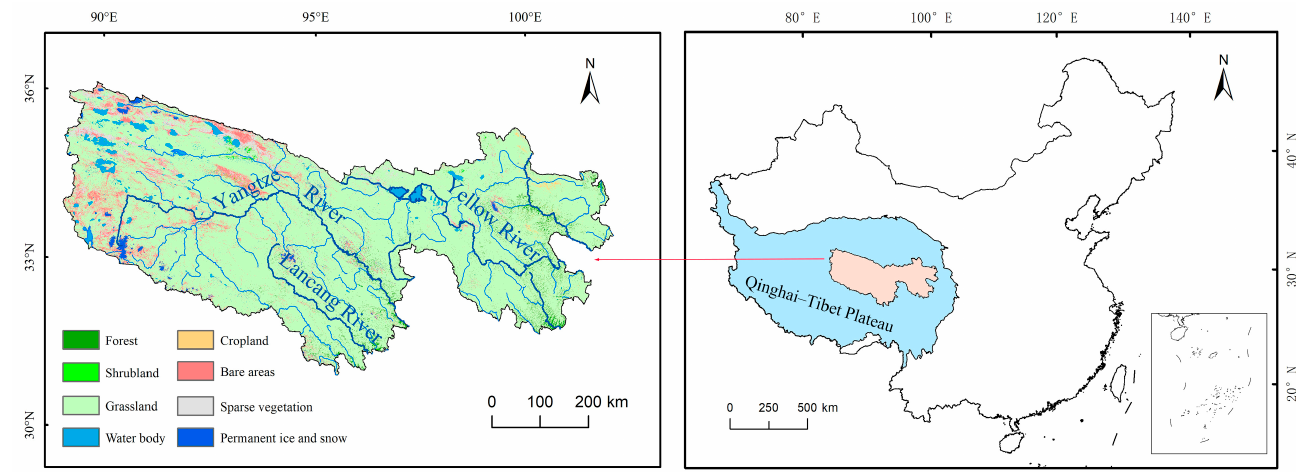
Figure 1. Location of the study area and the regional land use